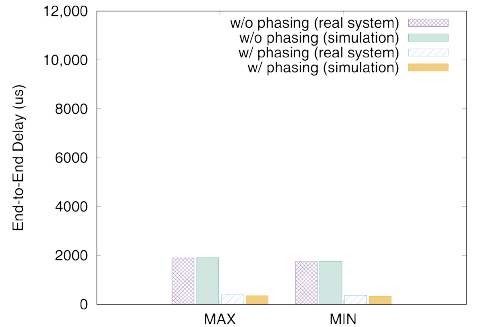
Figure 16. Max and min D e 2 e of VC 1 in test set 1.